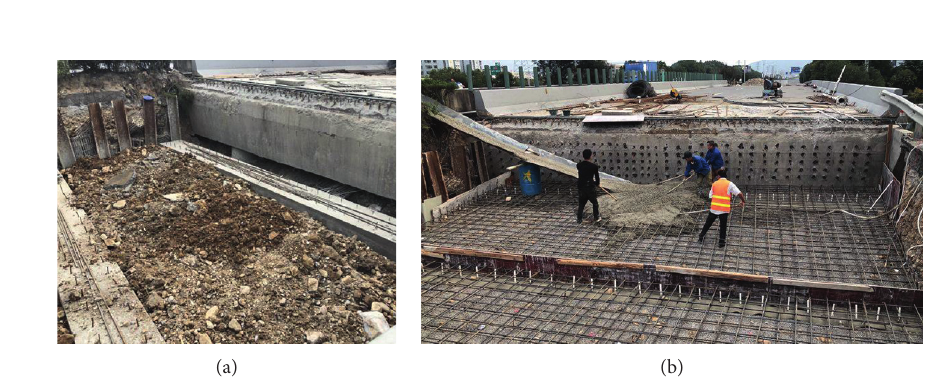
Figure 2: Construction site lower partition slab construction picture.